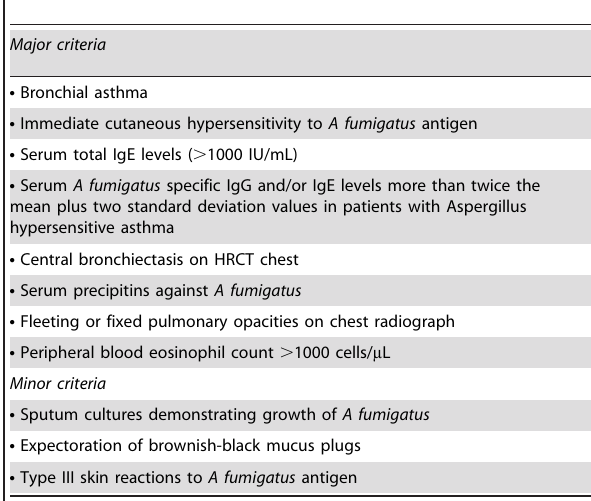
Table 6. Rosenberg-Patterson criteria for the diagnosis of allergic bronchopulmonary aspergillosis